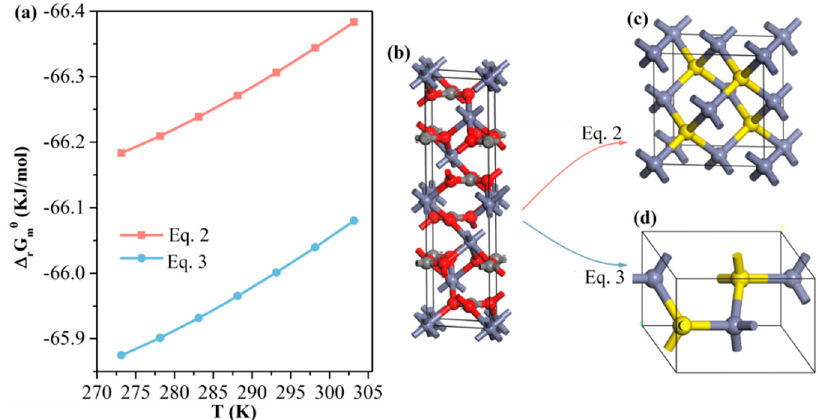
Figure 10. ( a ) ∆ r G m θ vs. temperature plot of Equations (2) and (3) calculated using HSC Chemistry ver.6.0 (Outokumpu Research, Pori, Finland); the relevant thermodynamic data are presented in Tables S1 and S2. Unit cell models of ( b ) smithsonite ZnCO 3 , ( c ) sphalerite-structured ZnS and ( d ) wurtzite-structured ZnS.